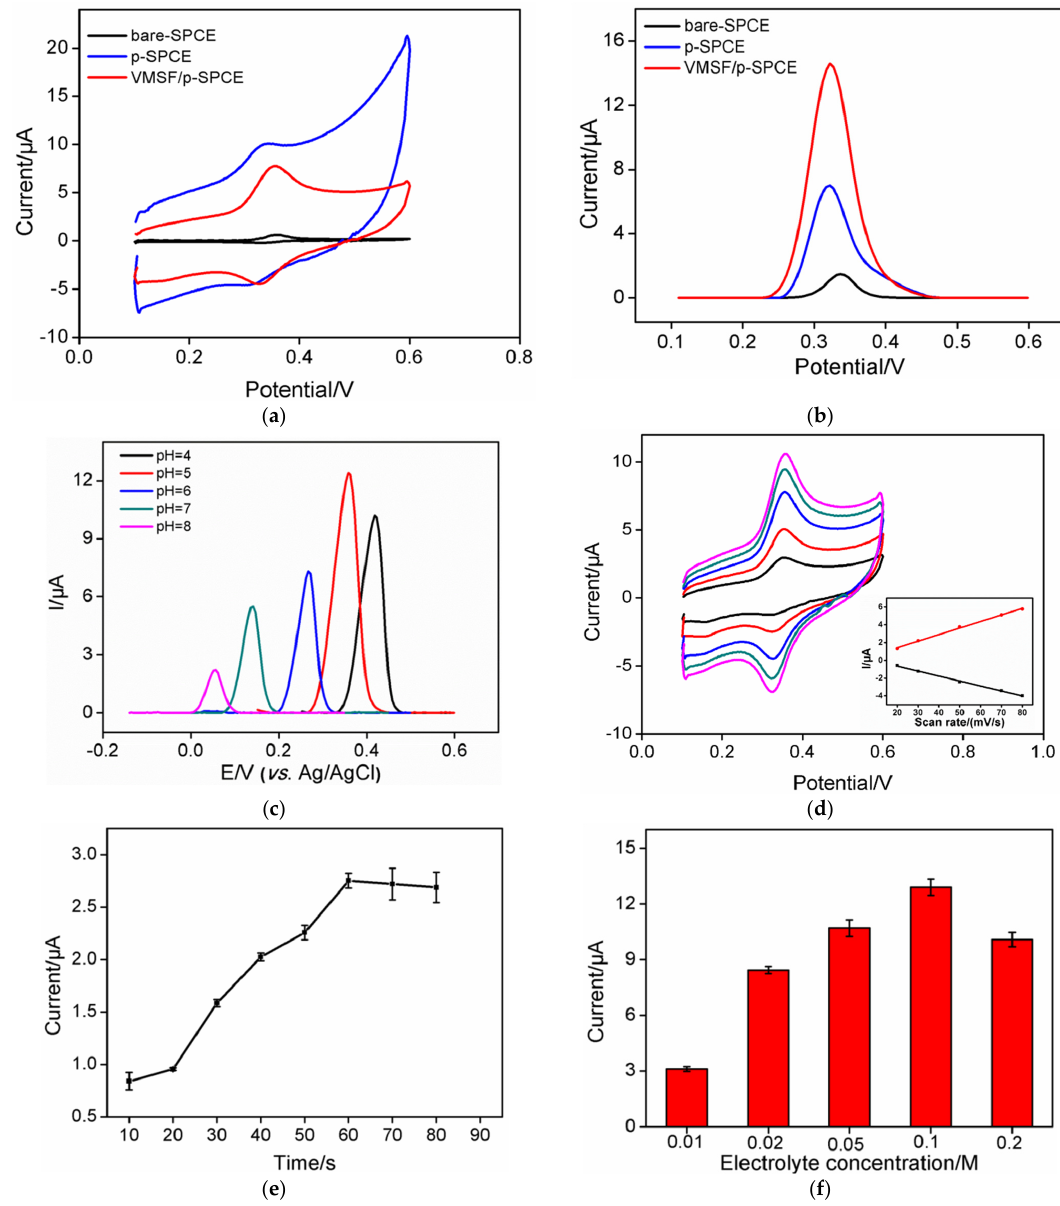
Figure 4. ( a ) CV or DPV ( b ) curves of CLZ on different electrodes. ( c ) DPV curves of CLZ at different pH. ( d ) CV curves of CLZ at different scan rates. The inset shows the linear regression curve between the peak current and the scan rate. ( e ) Effect of enrichment time on the peak current of CLZ. ( f ) Effect of the concentration of the electrolyte on the peak current of